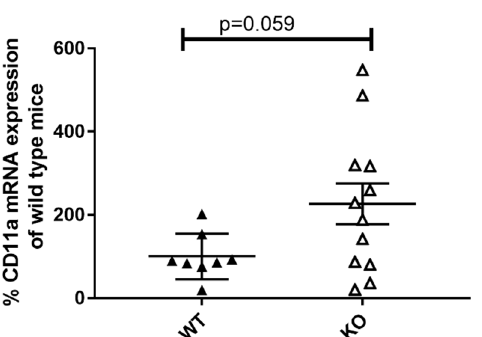
Figure 5. Characterization of CD11a expression in the kidneys of 19-week-old female MRL-Fas lpr KSRP − / − mice compared to MRL-Fas lpr KSRP +/+ mice (a) RNA was isolated from the kidneys of 19-week-old female MRL-Fas lpr KSRP − / − mice (KO) and MRL-Fas lpr KSRP +/+ mice (WT). CD11a mRNA expression was analyzed by qRT-PCR and normalized to the mRNA expression of Pol2a. Data presented are the mean ± SEM of the relative mRNA expressions based on WT females at 19 weeks (100%), 8 to 12 animals per genotype ( t -test).